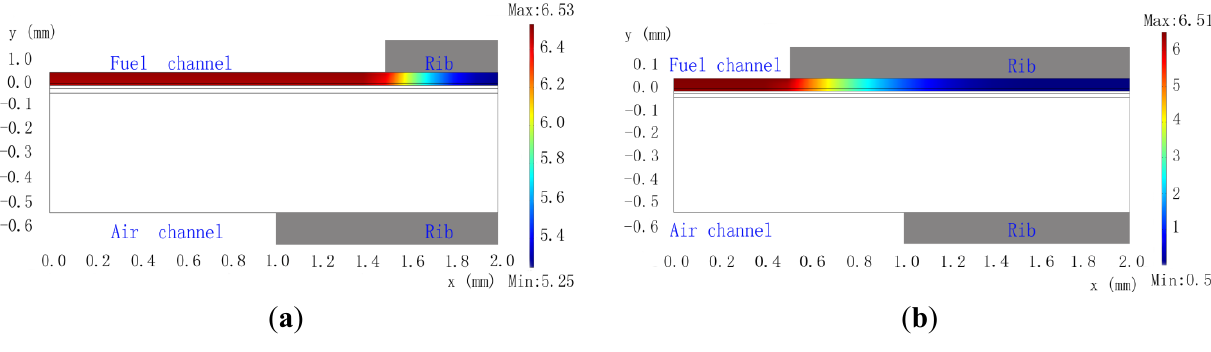
Table 7. The output current densities for different V